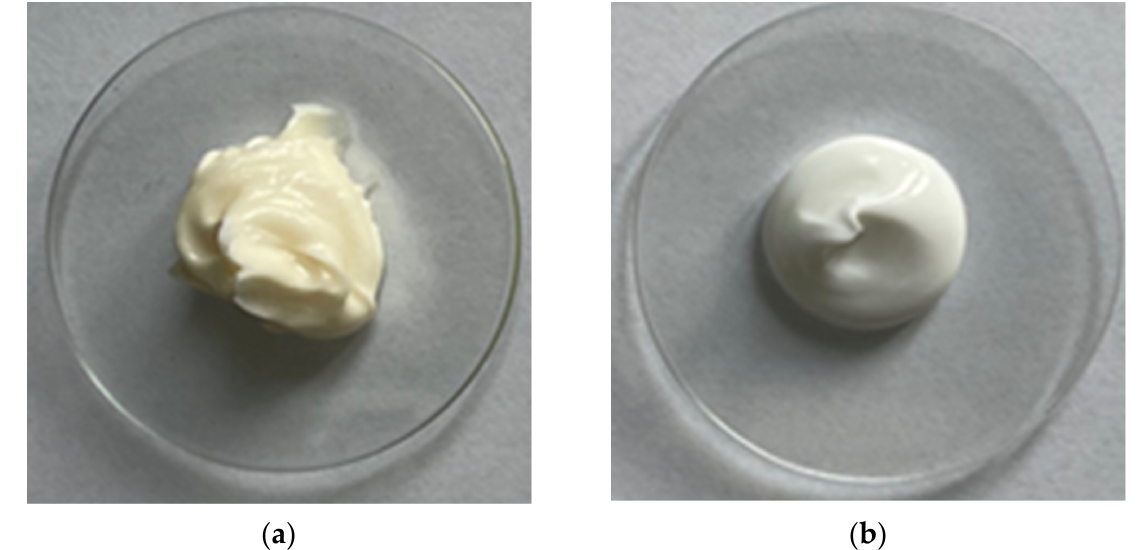
Figure 1. The comparison of formulation of the vehicle used ( a ) and a commercial product ( b ).